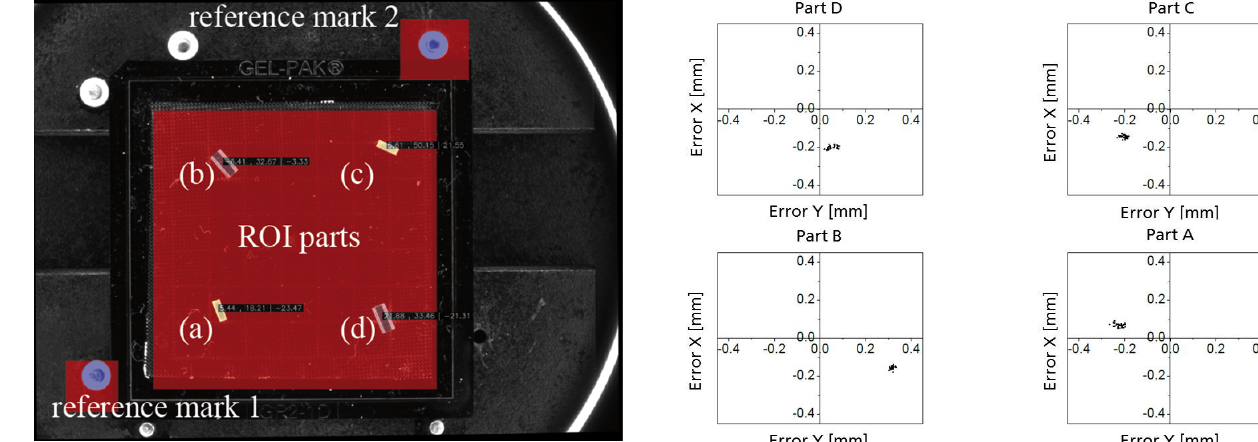
Figure 13. The identified parts of Fig. 12 have each been ap- proached by the robot in a way that the image center of the mobile camera is overlaid with the center point of each